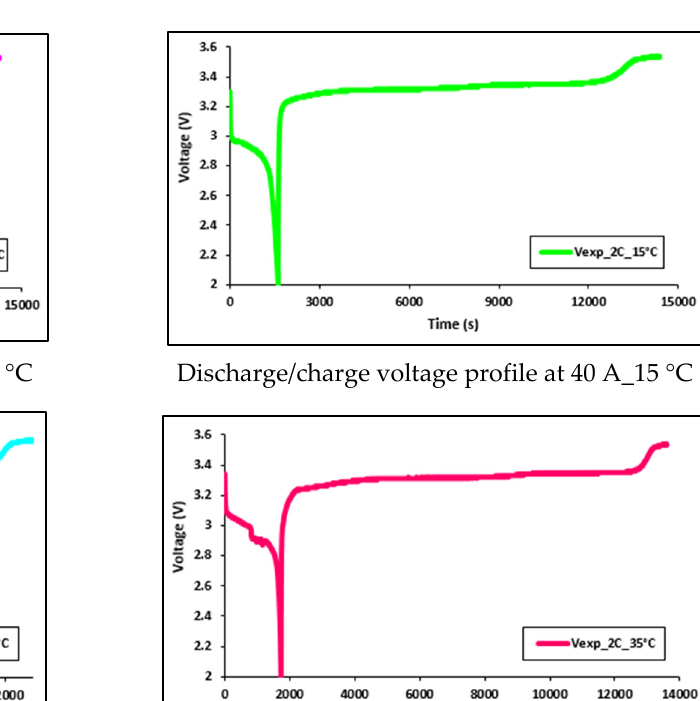
Figure 19. Discharge/charge voltage profile at 20 A with 5 °C, 15 °C, 25 °C, and 35 °C.